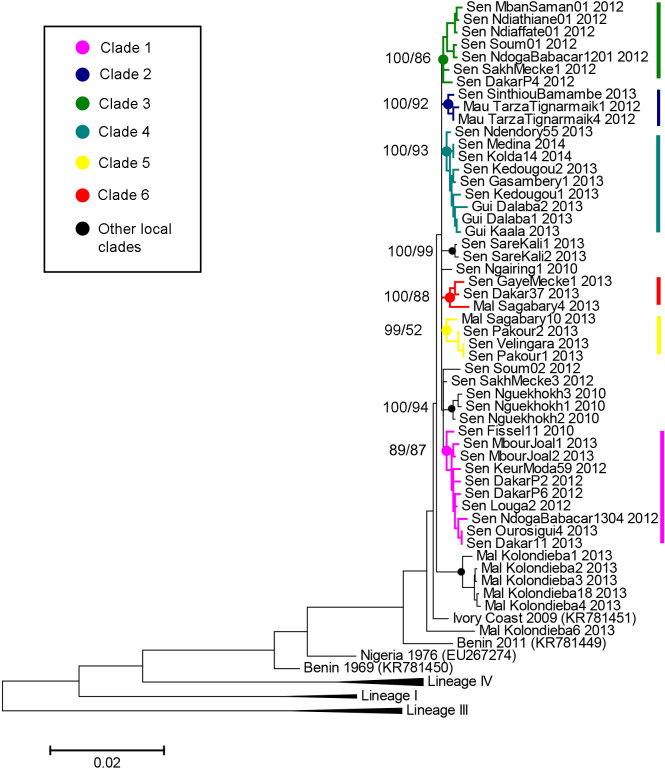
Phylogenetic analysis based on concatenated PPRV N and H complete coding regions.Phylogenetic tree constructed using a maximum likelihood inference method showing the relationship based on N and H gene sequences of peste des petits ruminants virus (PPRV) samples collected in Guinea, Mali, Mauritania and Senegal (see S1 Table for details). Genetic clusters of interest to this study are indicated by coloured branches. The numbers at the nodes indicate support from posterior probability/bootstrap values (> 50%) obtained with Bayesian inference and maximum likelihood methods, respectively.